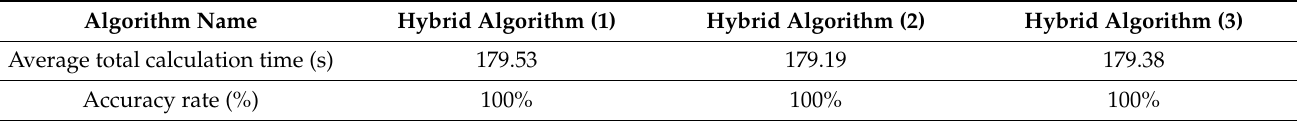
Table 3. Results of hybrid algorithms based on different region